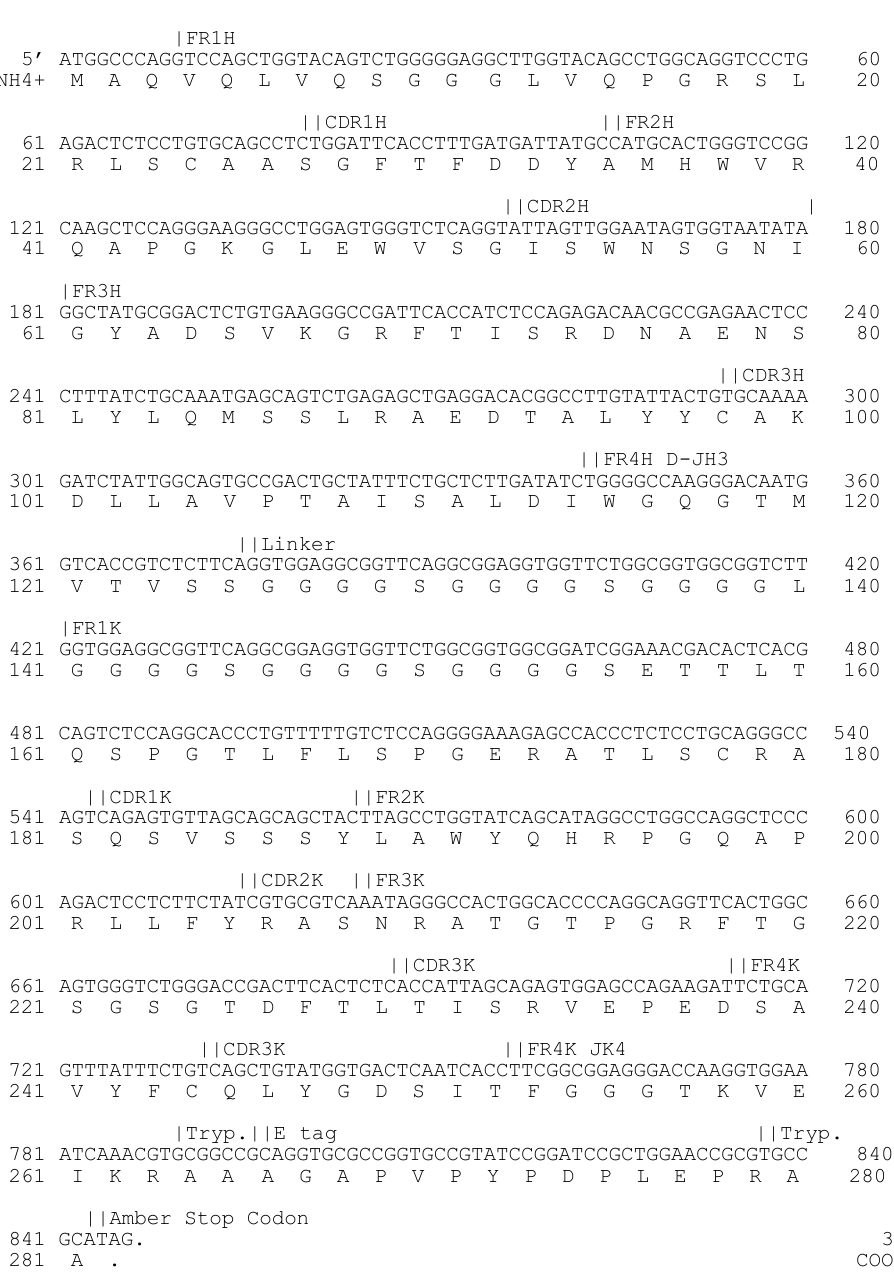
Figure 1. Genome sequence (upper lines) and amino acid sequence (lower lines) of variable domains of heavy (H) and kappa light ( κ ) chain of the scFv 3E2. The variable region consists of four framework regions (FR1-4) and three hypervariable complementarity-determining regions (CDR1-3). Trypsin-sensitive sites (Tryp.) are needed for the elution of bound phages by enzymatic cleavage with trypsin.